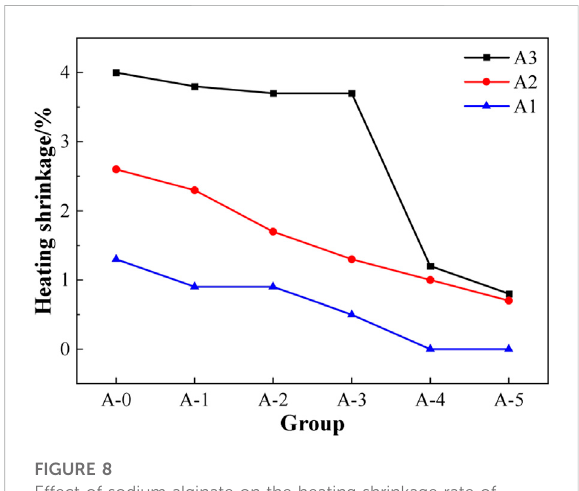
FIGURE 8 Effect of sodium alginate on the heating shrinkage rate of microbial repair